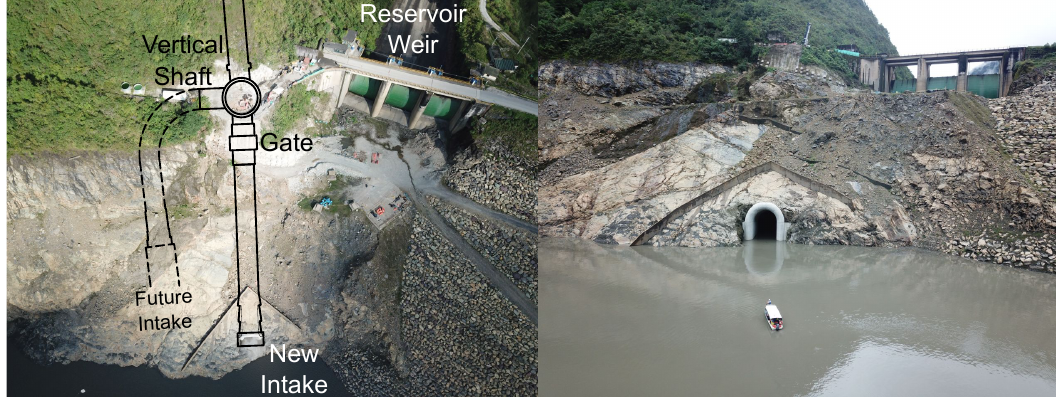
Figure 11. New intake at La Esmeralda